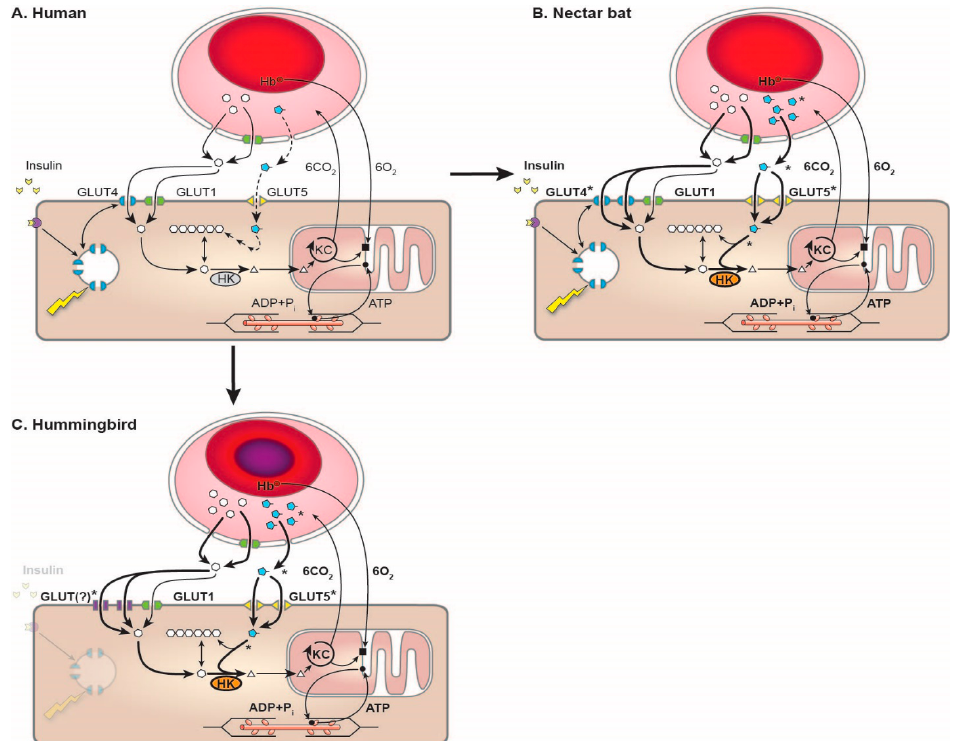
Figure 6. Comparison of mechanisms of muscle uptake and oxidation of circulating glucose and fructose in humans, nectar bats and hummingbirds. ( A ) Pathway for uptake and oxidation of mainly glucose into human skeletal muscle fibers, highlighting key regulatory steps (e.g., sarcollemal transport, regulation of transport capacity via insulin and contractile activity; ( B ) Glucose and fructose uptake and oxidation in nectar bats highlighting enhancements (in bold; those hypothesized are noted by asterisks) to various pathway elements; ( C ) Glucose and fructose uptake and oxidation in hummingbirds highlighting key upregulated steps (bold and asterisks used as in ( B )). Details regarding functional enhancements are discussed in the main text and in Welch and Chen [63]. Figure from [63].